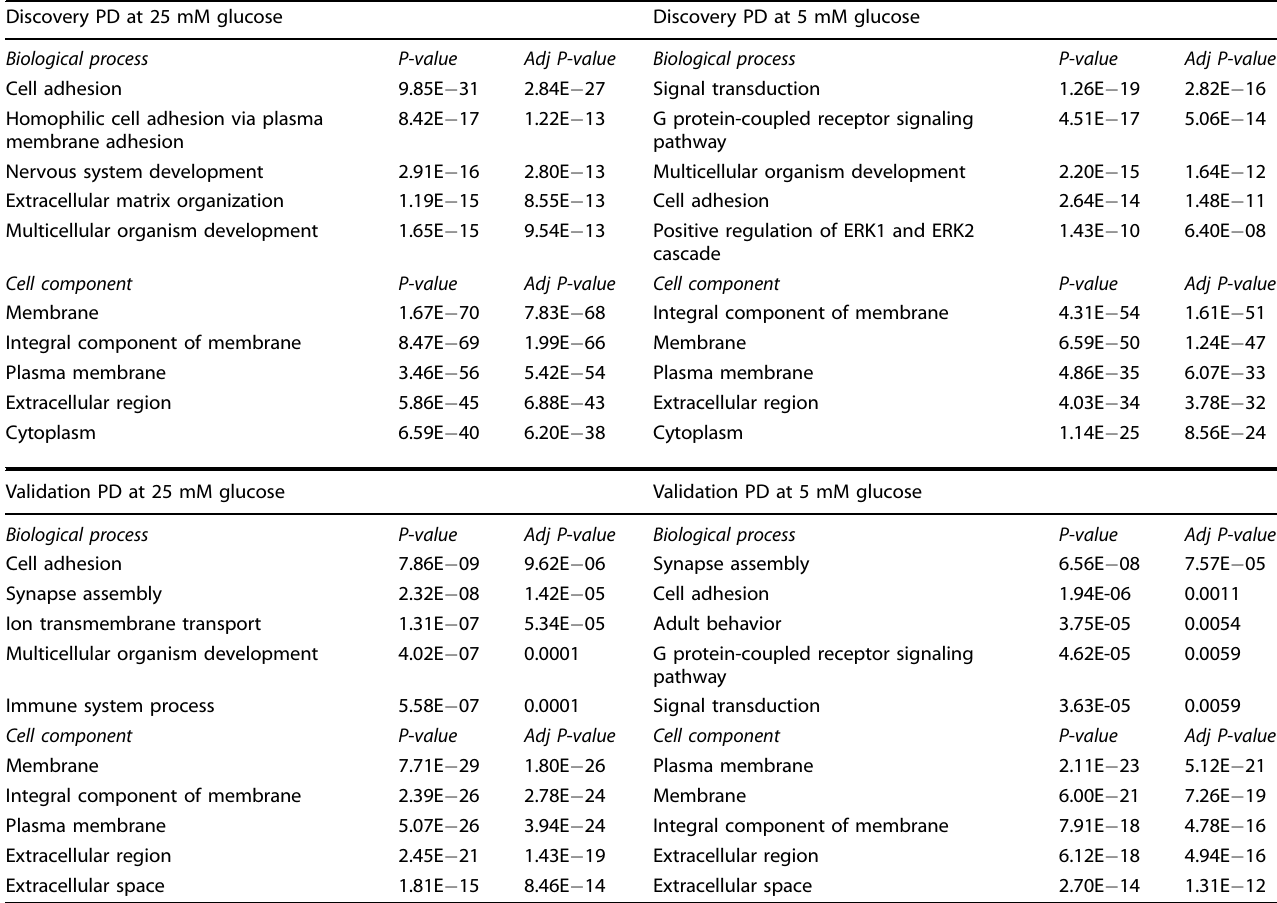
Table 1. Biological enrichment analysis in all PD vs.